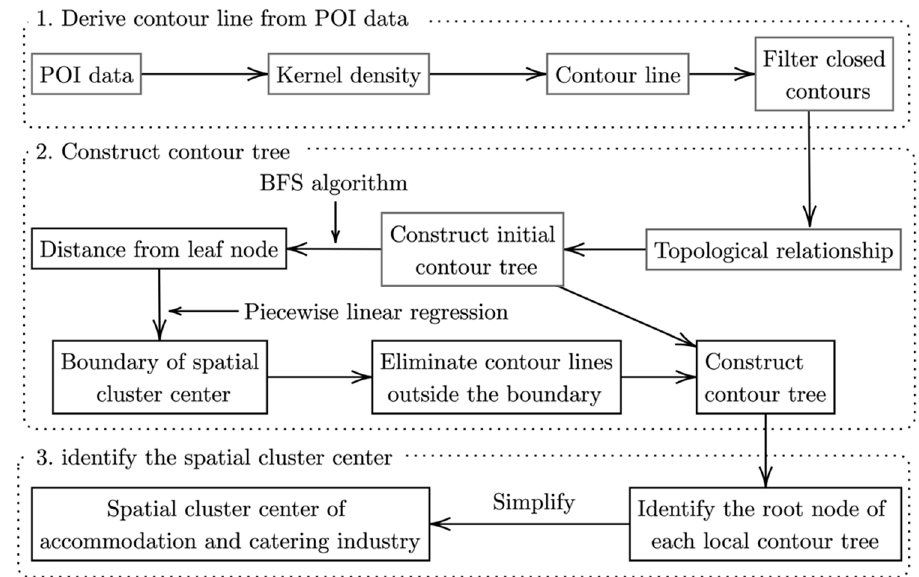
Figure 6. Flowchart showing the steps for the identification of the urban industrial spatial cluster center.